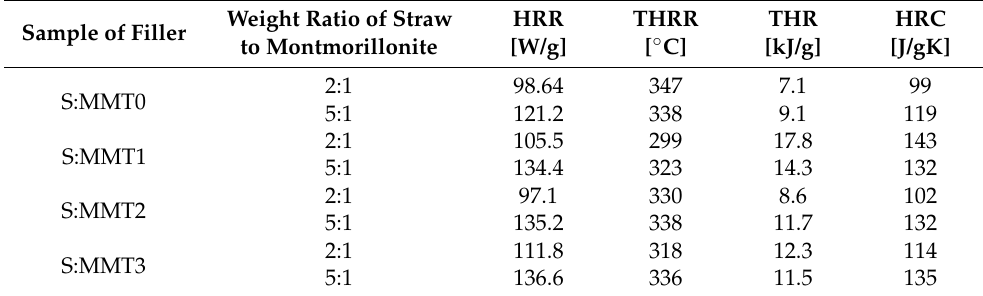
Table 4. Flammability results of fillers determined with a microcalorimeter; standard